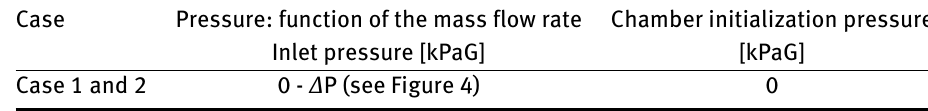
Table 4: Inlet pressure boundary and initial conditions for both cases under